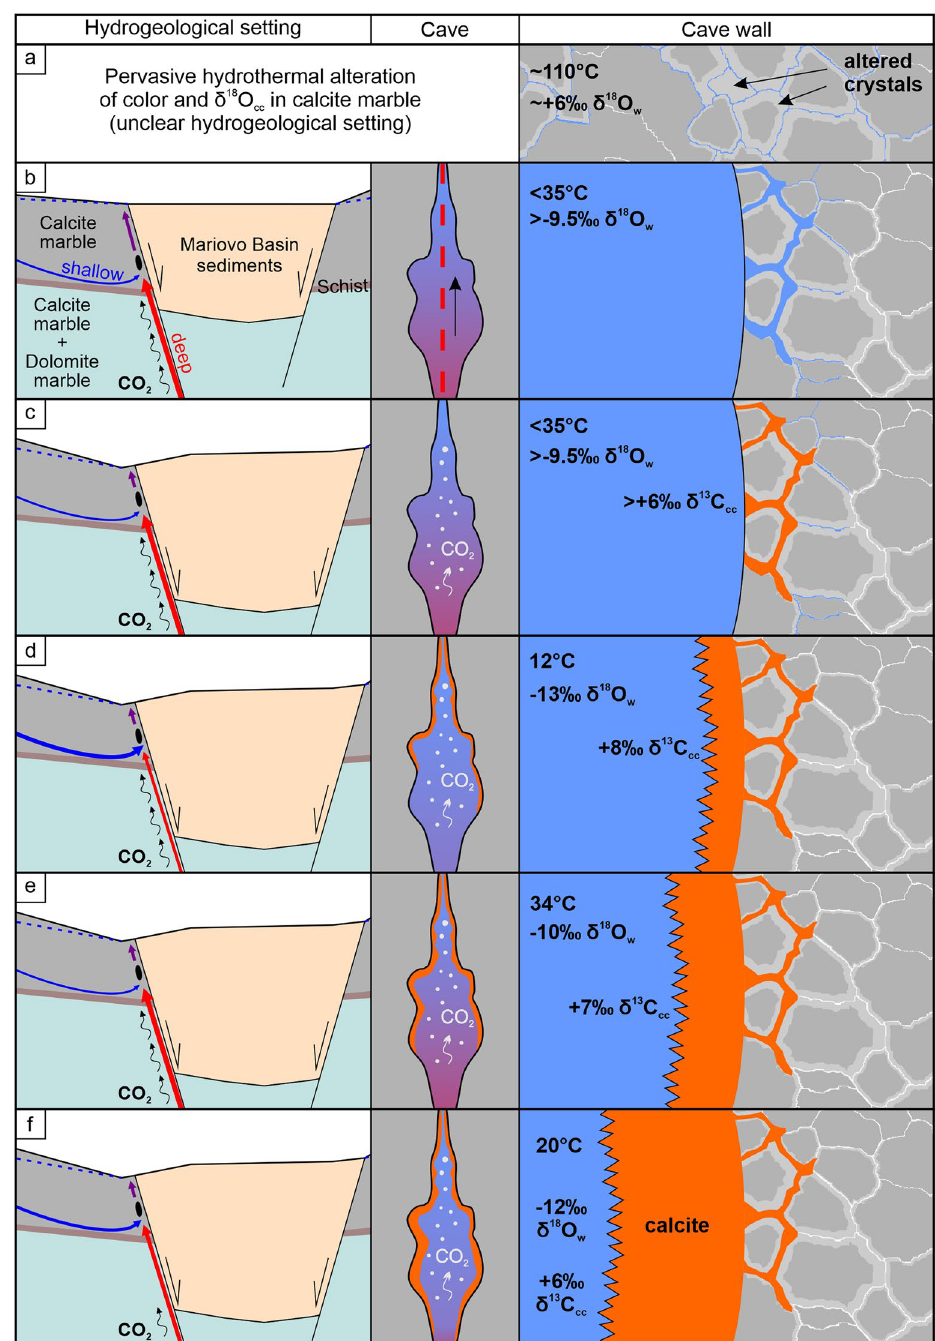
Figure 7. Conceptual model of the evolution of the studied hydrothermal phases in Provalata Cave with associated alteration mechanisms and calcite deposits presented schematically at three scales: hydrogeological setting, cave and cave wall. The thickness of the blue and red groundwater flowlines in each phase indicates the relative influence of the shallow epigene and deep hypogene component, respectively. ( a ) Pervasive alteration of color and δ 18 O cc in calcite marble by hydrothermal water (~ 110 °C) with oxygen diffusion along crystal boundaries as the most likely alteration mechanism. The hydrogeological setting is unclear. ( b ) Development of cave passages along high-angle fractures due to cooling of low-temperature (< 35 °C) thermal waters rich in metamorphic CO 2 , likely enhanced by mixing corrosion. Porosity increases perpendicularly to the cave wall. ( c ) Shift to shallower depth leads to CO 2 degassing and calcite precipitation, filling up pore spaces. ( d ) Large decrease in temperature and δ 18 O w , indicating increased influence of the shallow groundwater component. Calcite with high δ 13 C cc values precipitates outward from the cave wall. ( e ) Increase in temperature and δ 18 O w , likely related to nearby volcanic activity, leads to precipitation of calcite with lower δ 13 C cc . ( f ) Temperature and δ 18 O w decrease. Lowering of pCO 2 leads to decrease in calcite δ 13 C cc